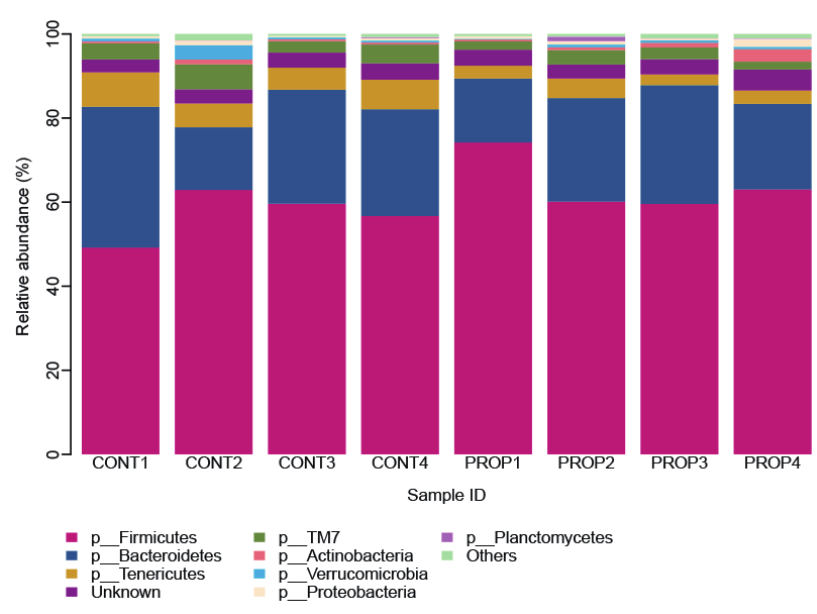
Figure 1. Phylogenetic composition of bacterial taxa at the phylum level.